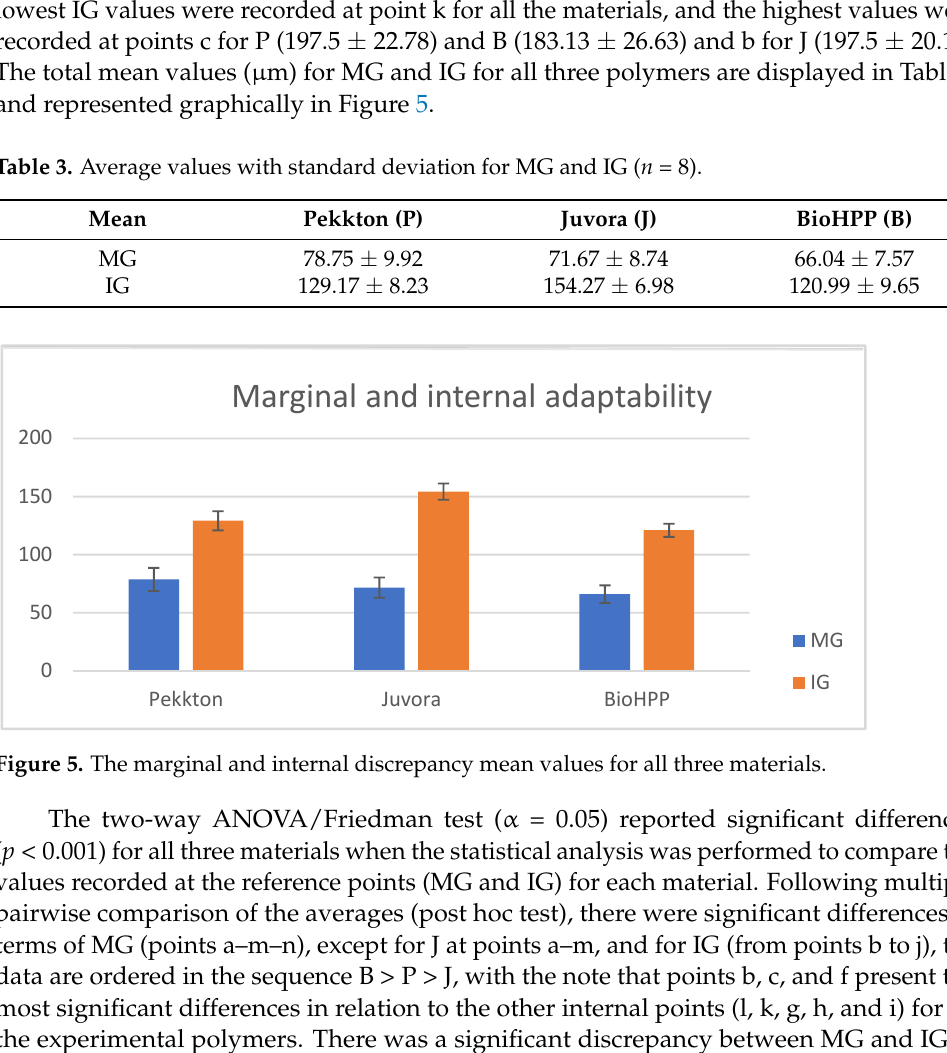
Figure 4. Average values obtained at the reference points of the both sections.